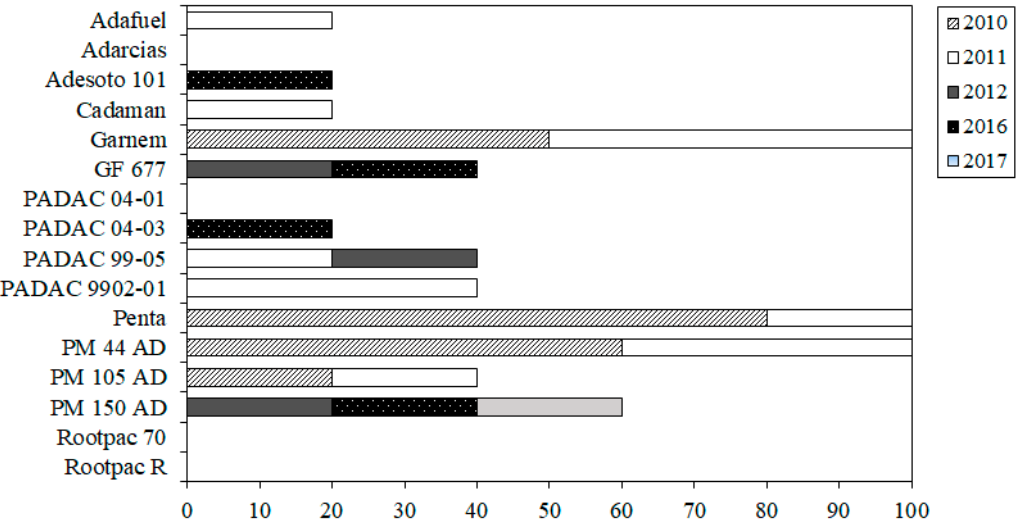
Figure 1. Tree mortality rate (%) from the second (2010) to the ninth (2017) year after planting. No trees were lost in the period 2013–2015.